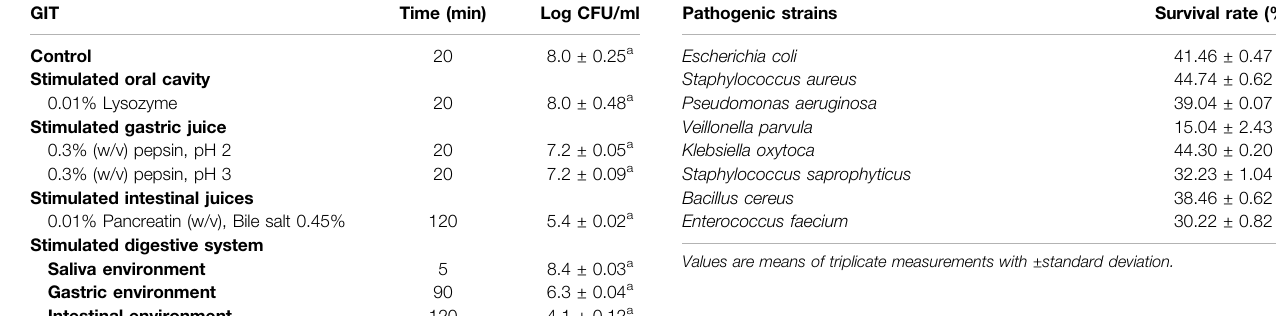
TABLE 3 | Gastrointestinal transit tolerance of Bacillus paranthracis MHSD3. GIT